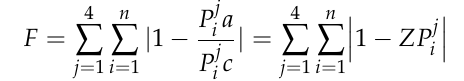
Figure 3. Calculation process of RFOM, based on the GA.